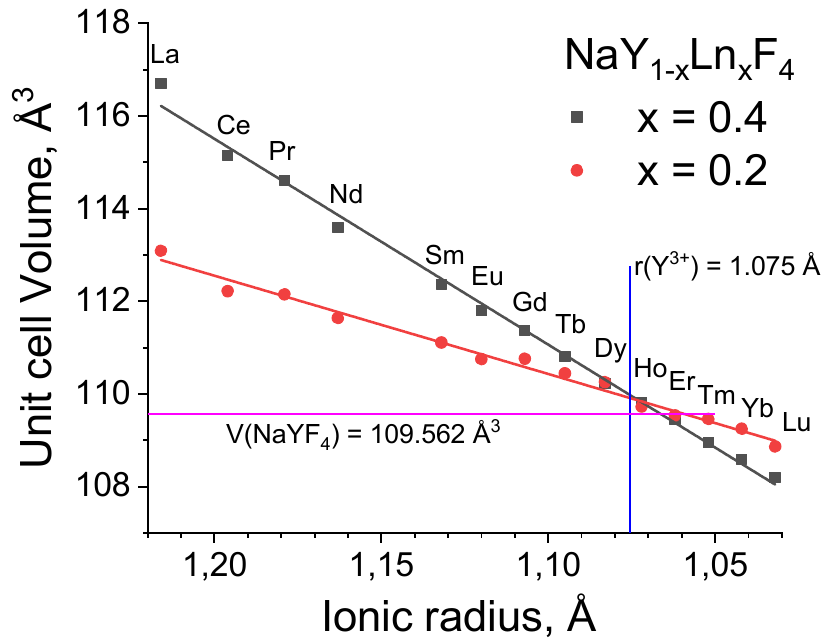
Figure 2. The dependence of unit cell volumes of NaY 0.8 Ln 0.2 F 4 and NaY 0.6 Ln 0.4 F 4 (Ln = La–Nd, Sm–Lu) on the ionic radii of Ln 3+ ions (the coordination number is equal to 9). The ionic radius of Y 3+ is shown as blue line for comparison. The unit cell volume of NaYF 4 is shown as magenta line.